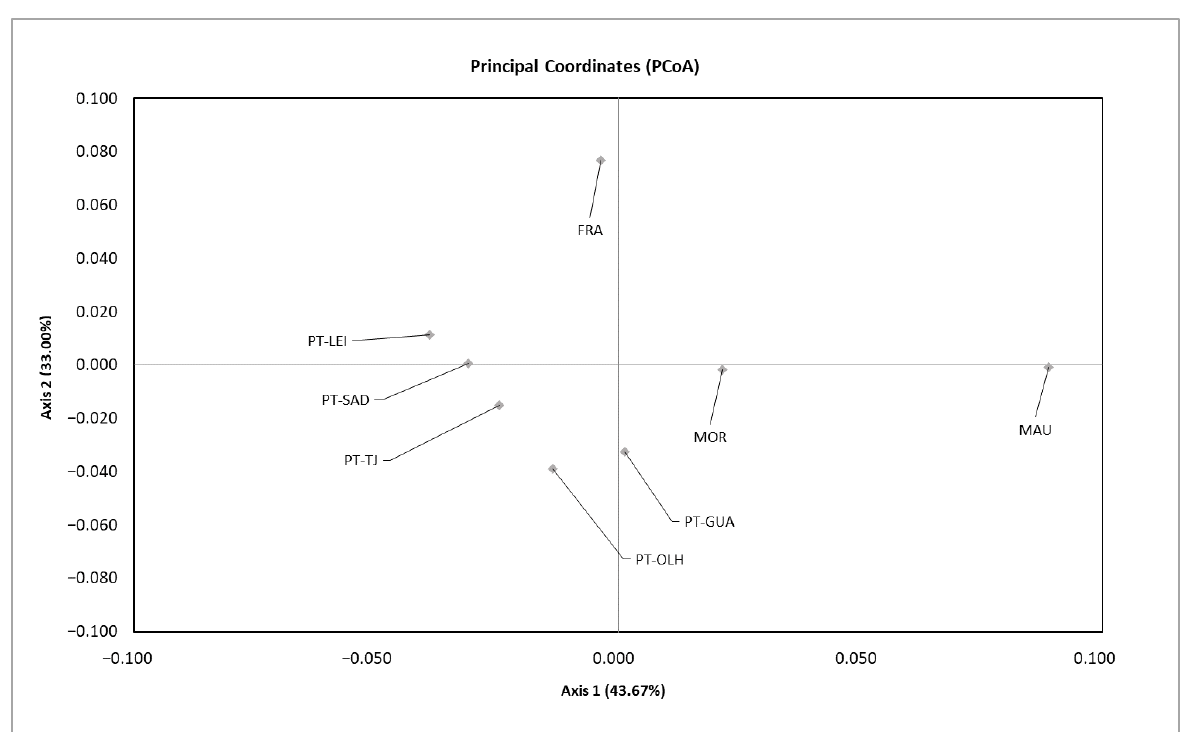
Figure 3. Principal coordinates analysis plot (PCoA) based on the pairwise estimates of F ST values among Argyrosomus regius Atlantic location sites. For location sites’ acronyms, please check Table 1. Table 6. Argyrosomus regius Atlantic effective population size (Ne) estimated for each location site with linkage disequilibrium (parametric and jackknife methods) and heterozygote excess method (parametric method). Ne values and respective upper and lower 95% confidence interval, at critical frequency threshold value of 0.05. For location sites’ acronyms, please check Table 1.